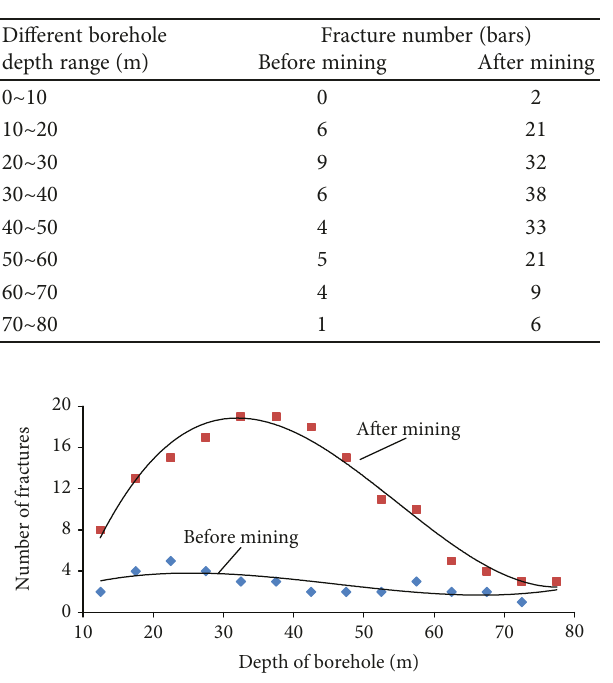
Table 5: Fracture numbers with di ff erent borehole depths before and after mining.